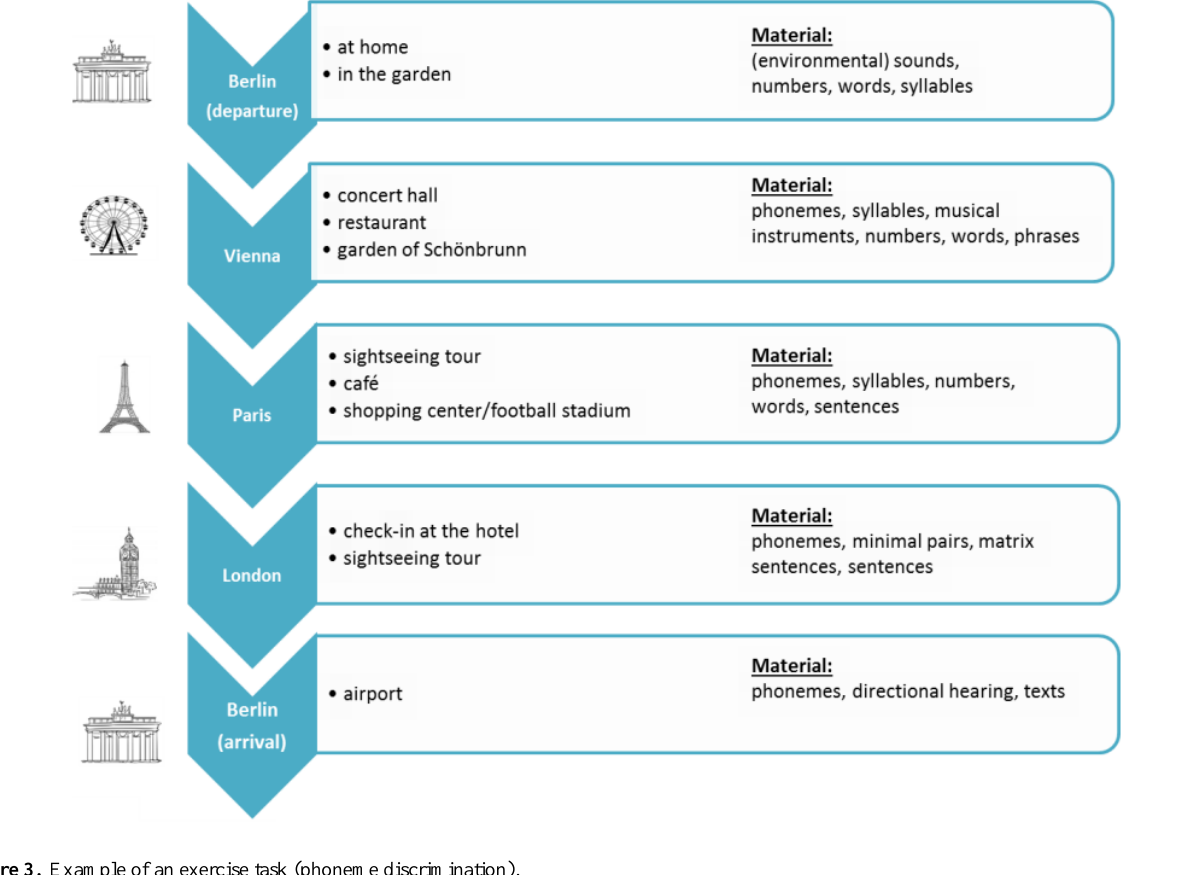
Figure 3. Example of an exercise task (phoneme